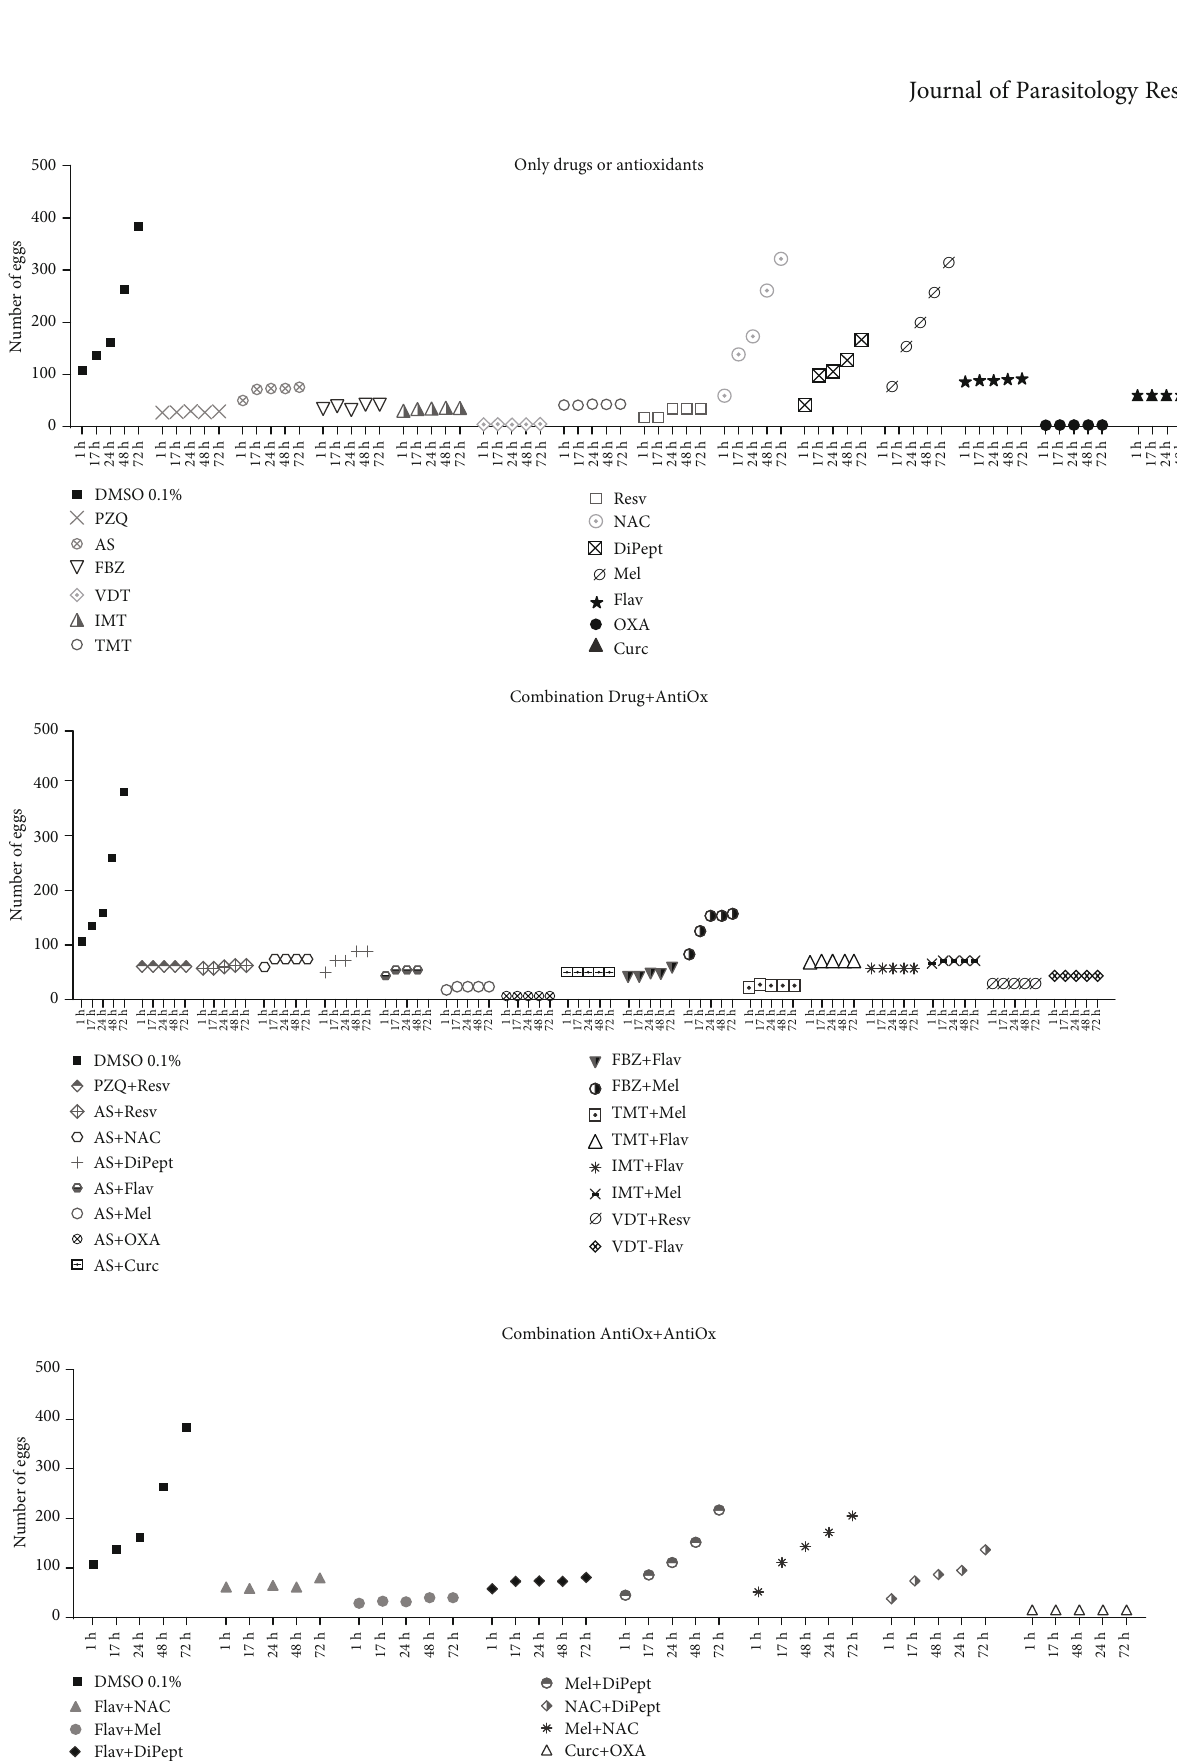
Figure 3: Number of eggs observed in vitro assay after drug/antioxidant